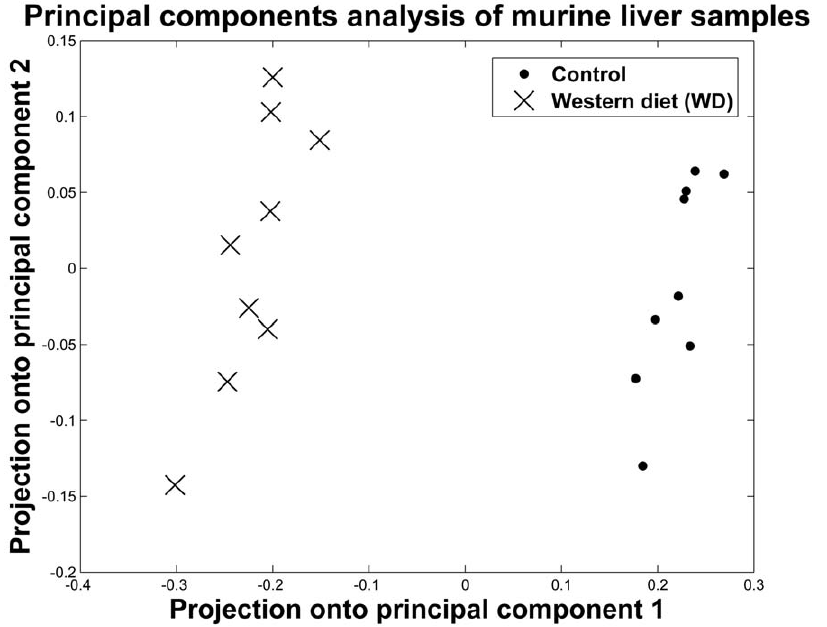
Figure 7. Principal component analysis of murine lipidomics data. Murine samples for different diets (control, dots; Western diet=WD, crosses). All replicates are shown.